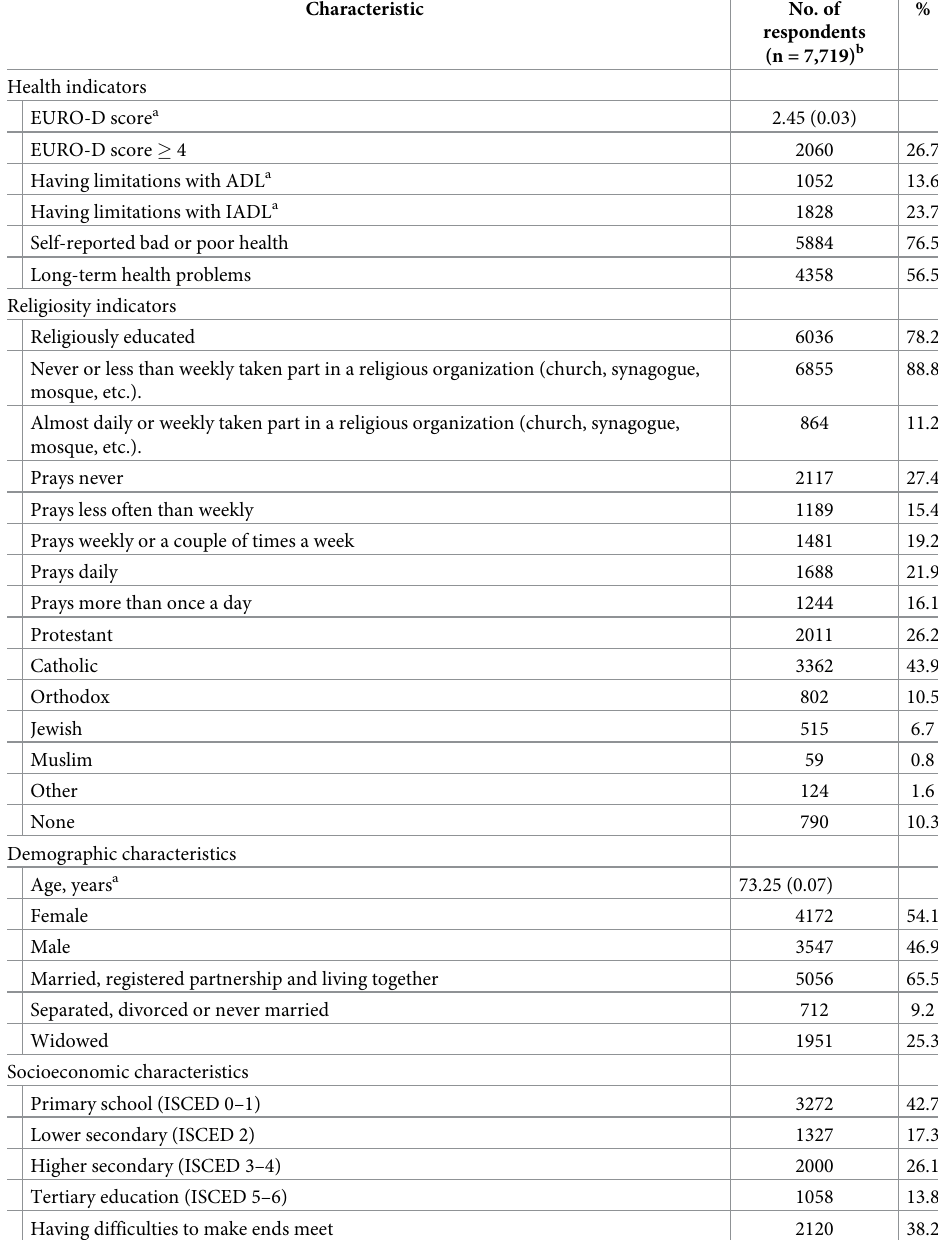
Table 1. Baseline characteristics of selected respondents aged 65 years or older in the survey of health, ageing and retirement,